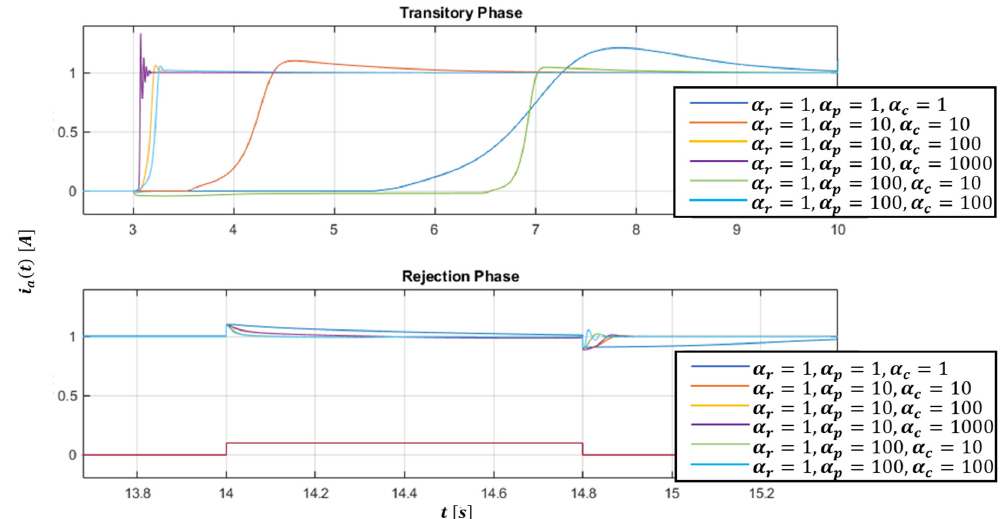
Figure 9. A particular view of the Transitory Phase ( a ) and Rejection Phase ( b ) of Figure 6.